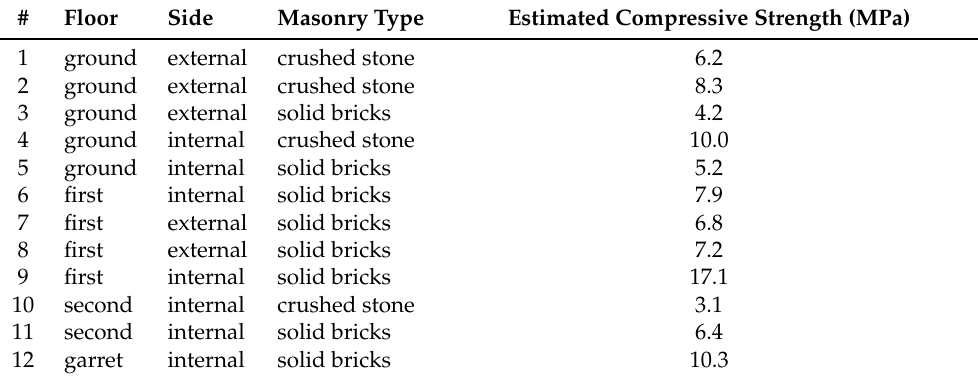
Table 1. Penetrometer tests on mortar.